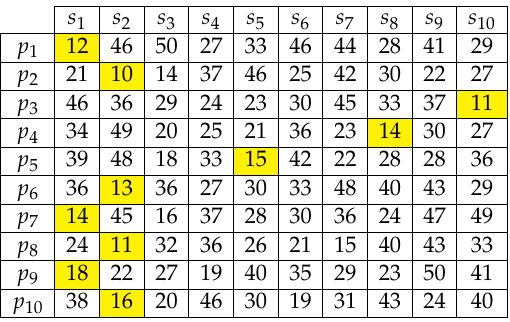
Table 1. Illustrative example of robust TEP. Numerical values represent social welfare of 10 transmission plans under 10 scenarios. For each transmission plan, the social welfare under the worst case scenario is highlighted.